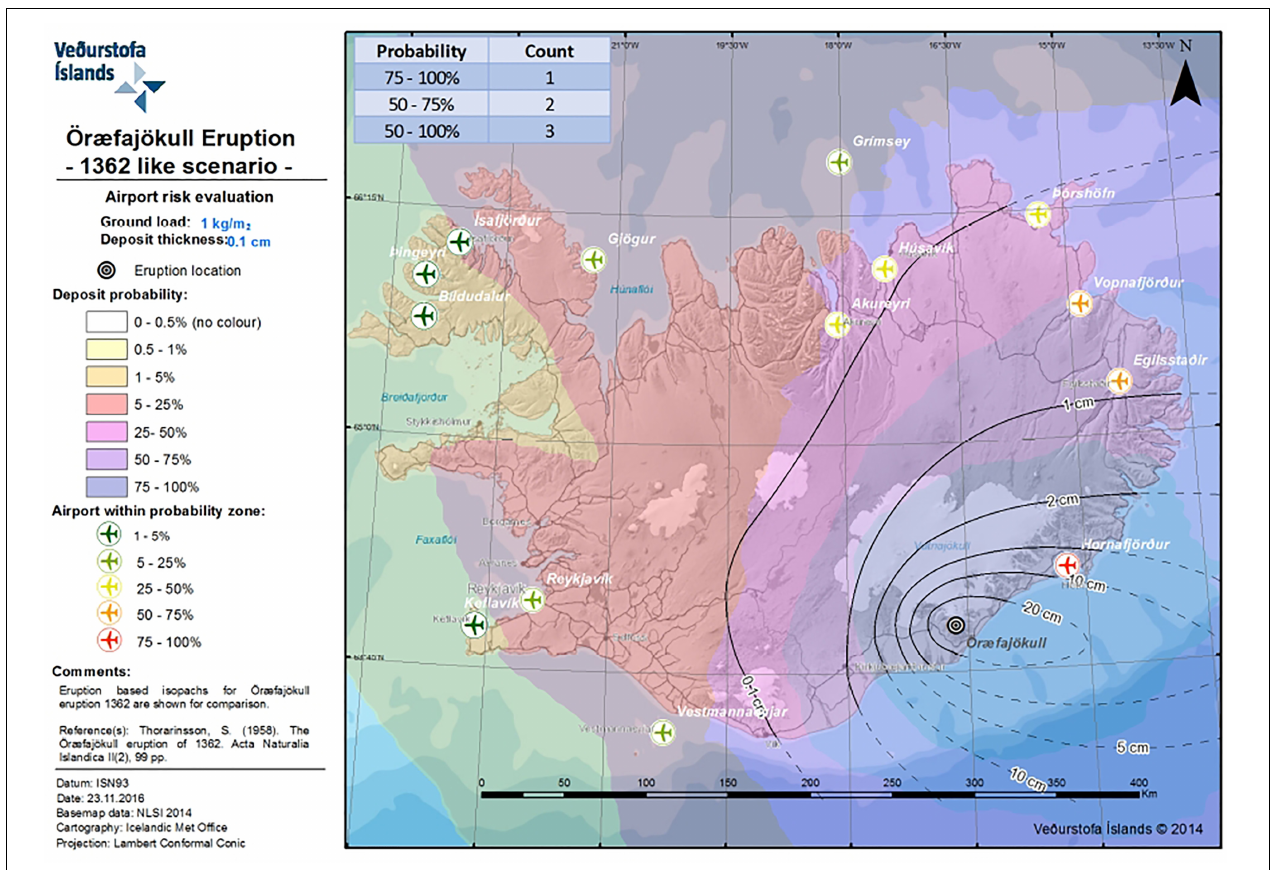
FIGURE 10 | Map showing potential tephra fallout impact to airport in case of a 1362-like eruption at